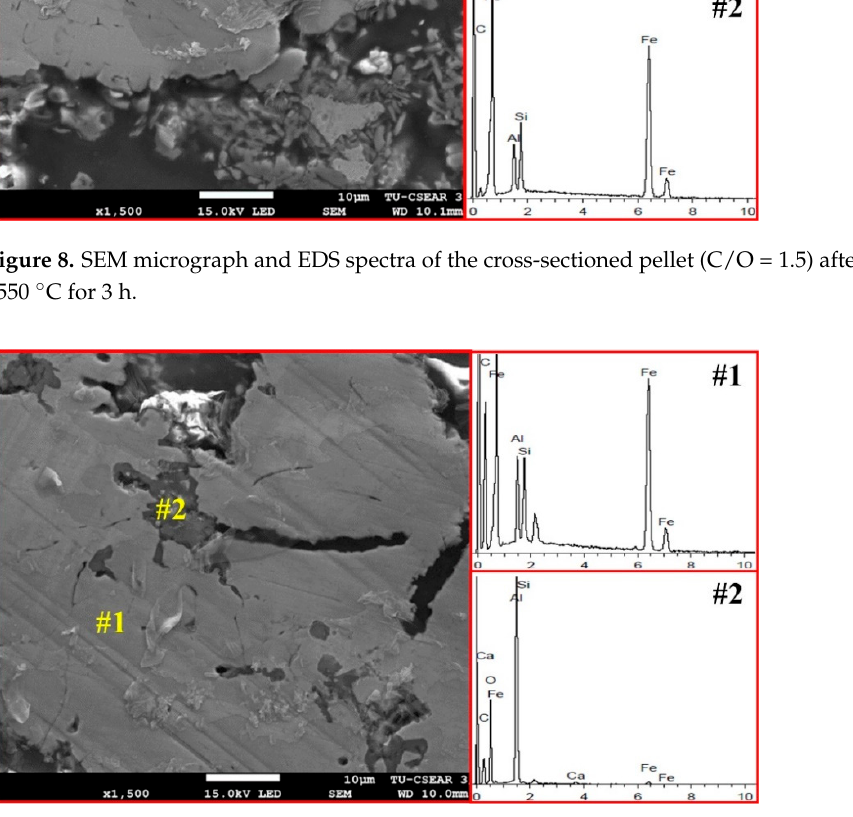
Figure 9. SEM micrograph and EDS spectra of the cross-sectioned pellet (C/O = 2) after heating at 1550 °C for 3 h. Table 4. Composition of the synthesis metals after heating for 3